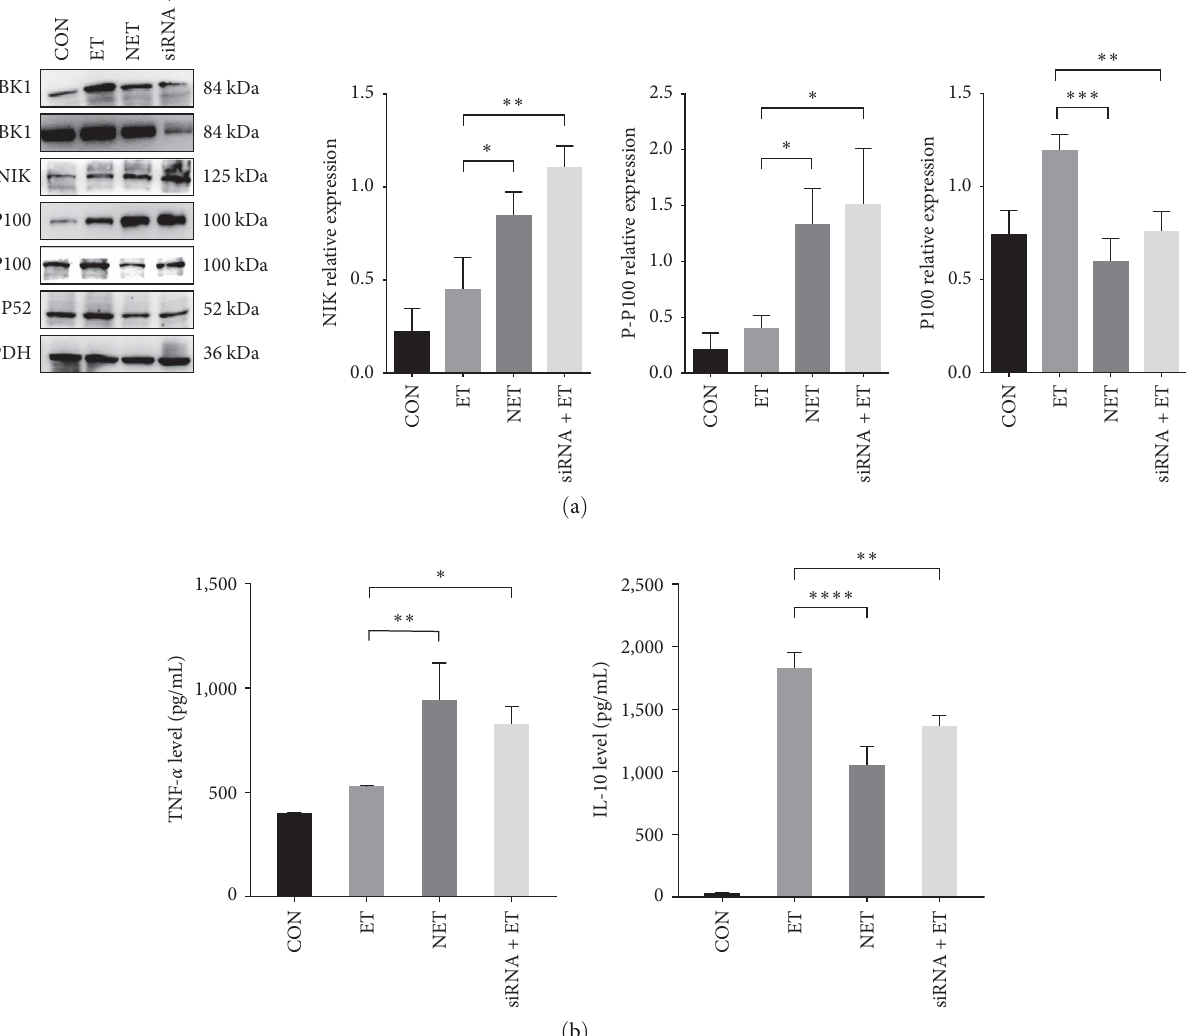
F IGURE 3: TBK1 induces endotoxin tolerance by negatively regulating p100 processing: (a) Western blotting analysis of p-TBK1, TBK1, NIK, P-P100, and NF- κ B/p100 protein expression. Densitometric analysis of the Western blotting data; (b) the expression of the TNF- α and IL-10 in the culture supernatant of RAW264.7 cells were detected by ELISA. Data are represented as the mean Æ SD of at least three independent experiments; one-way ANOVA with Dunnett ’ s multiple comparisons was used. ∗ p < 0 : 05, ∗∗ p < 0 : 01, ∗∗∗ p < 0 : 001, ∗∗∗∗ p < 0 :